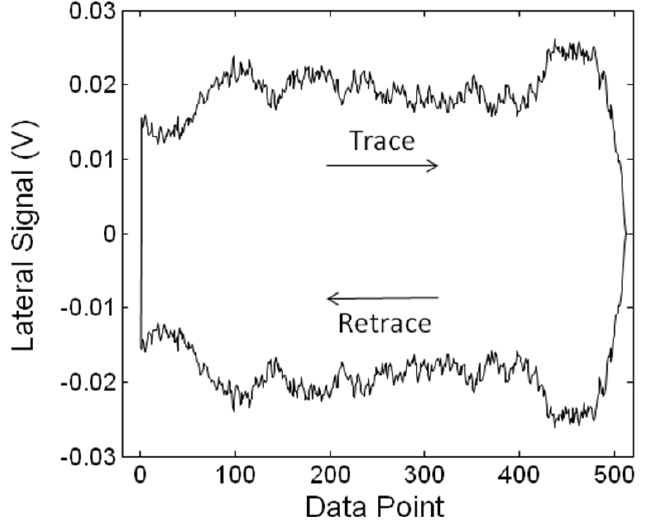
Figure 6. Representative lateral signal trace and retrace curves from a control VSMC at ~8 nN applied normal force. 512 data points were collected on each line. Recording trace and retrace data allows one to distinguish frictional from topographical effects on the lateral signal [19]; The friction signal (in V) is calculated as half the difference of the trace and retrace